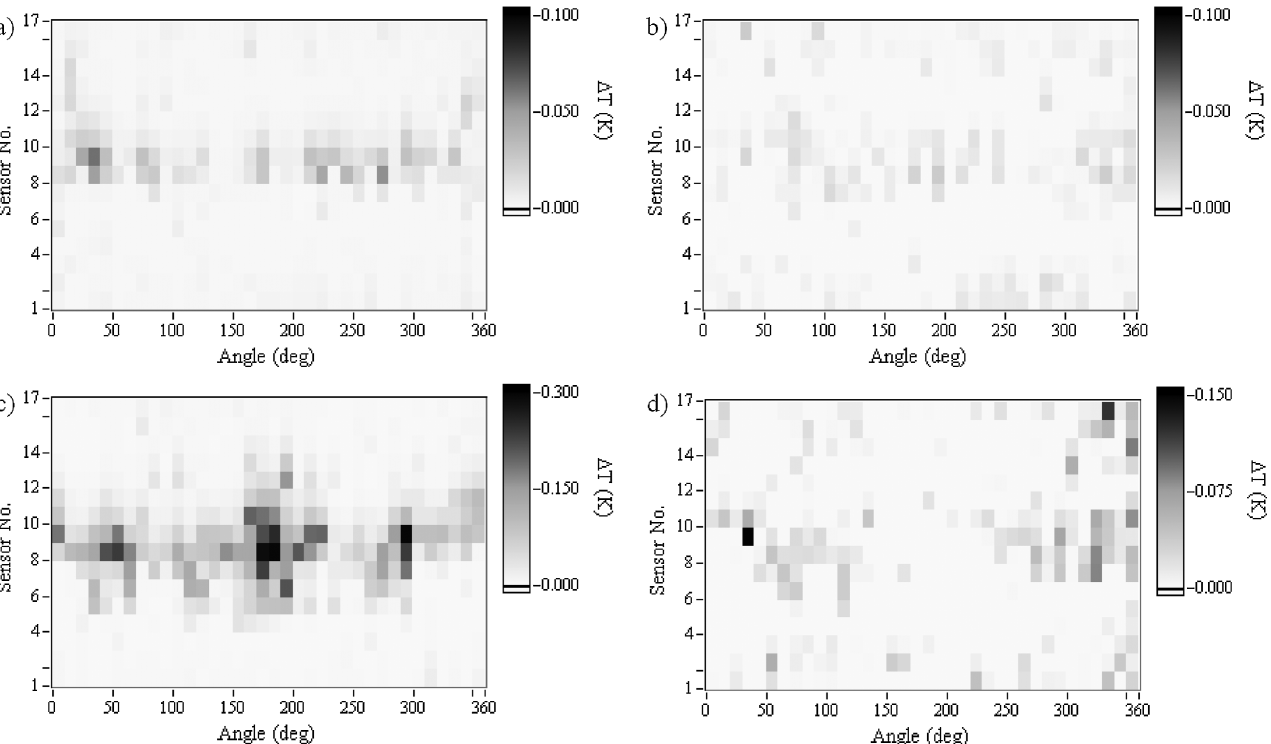
FIG. 9. ‘‘Unfolded’’ temperature maps at 1.7 K at the highest field achieved in the high-power rf tests of a large-grain CEBAF single- vs B data shown in Fig. 8) after storing in air for four months and filling with H cell cavity ( Q p 0 twice in H at 1 atm at 120 (cid:1) C for 12 h (b), after heat treatment at 600 (cid:1) C for 10 h in UHV (c), and after baking at 120 (cid:1) C for 12 h in 2 UHV (d). Note the different (cid:2) T scales. Strong hot spots causing the Q drop are visible in (c). Sensors No. 1 and 16 are located at the top and bottom iris of the cavity, respectively, while the equator weld is between sensors No. 8 and No. 9.